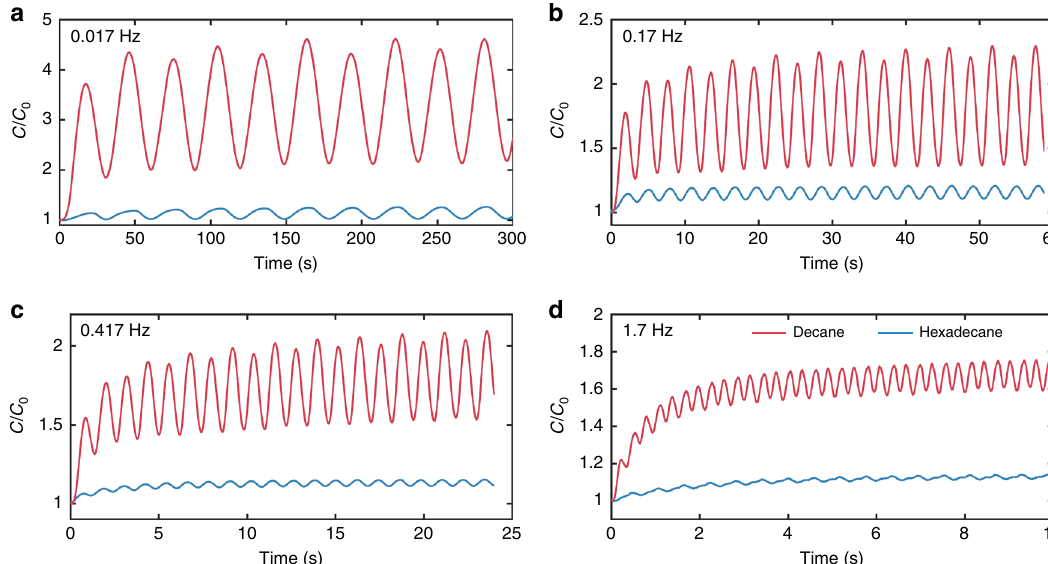
Fig. 2 Dynamical changes in membrane capacitance in response to sinusoidal voltage excitation. Governed by EW and EC, the capacitances of symmetrical DPhPC membranes formed either in decane or hexadecane increase in response to bipolar sinusoidal voltages (|150 mV|). Based on our experimental measurements, we found that for both oils and at all frequencies ( a – d ), DC capacitance exhibits a damped increase to a positive steady-state offset governed by the RMS value of the signal